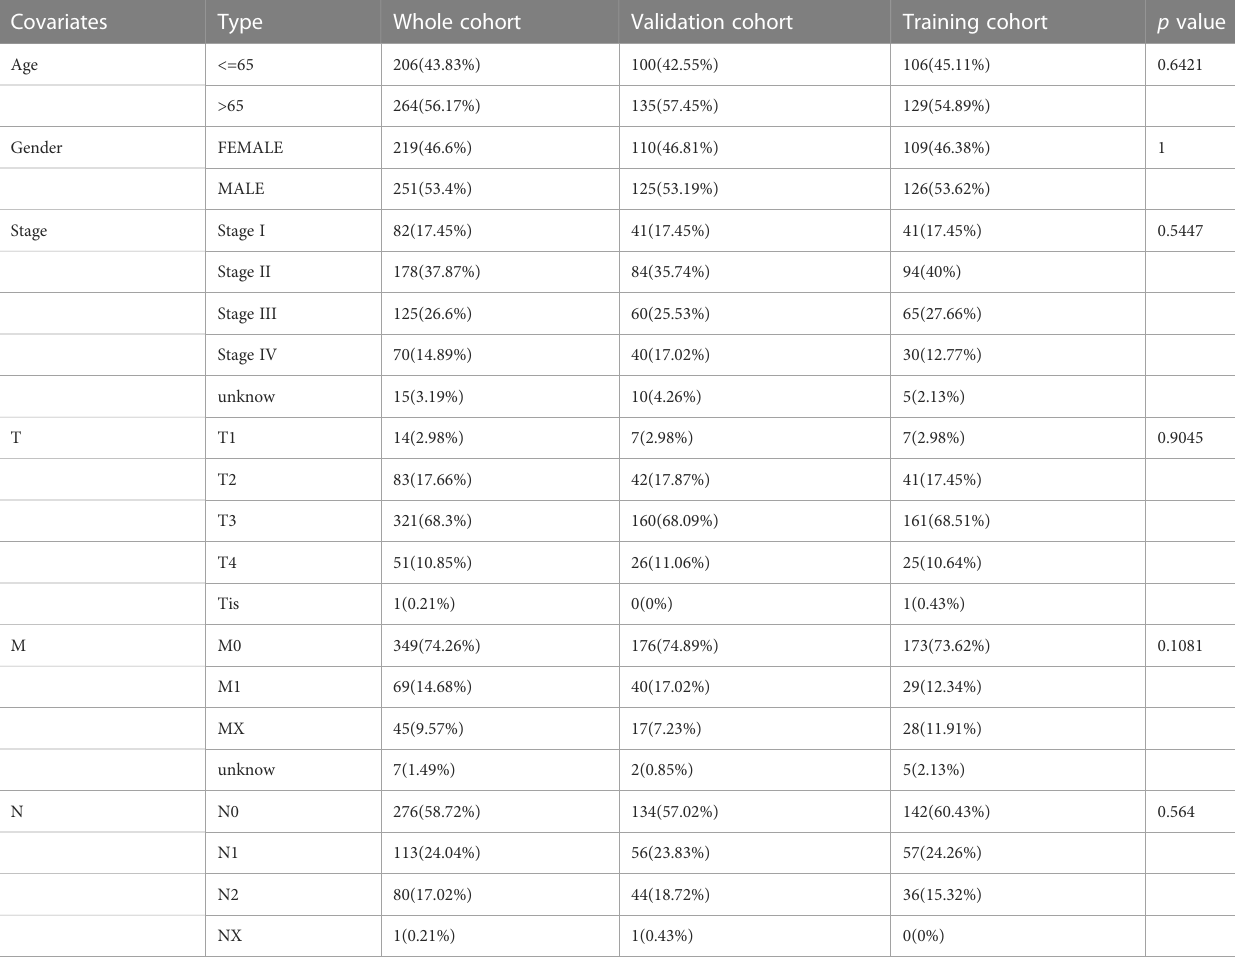
TABLE 1 Clinicopathological characteristics of the Whole cohort, training cohort, and validation cohort.